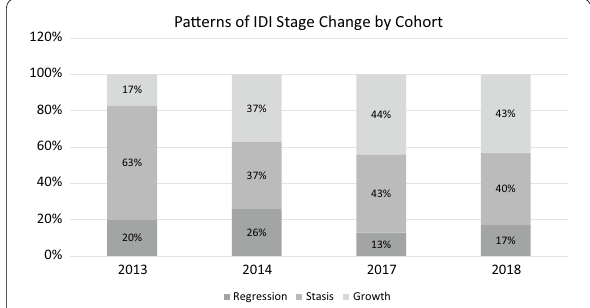
Fig. 2 Patterns of IDI stage change by cohort